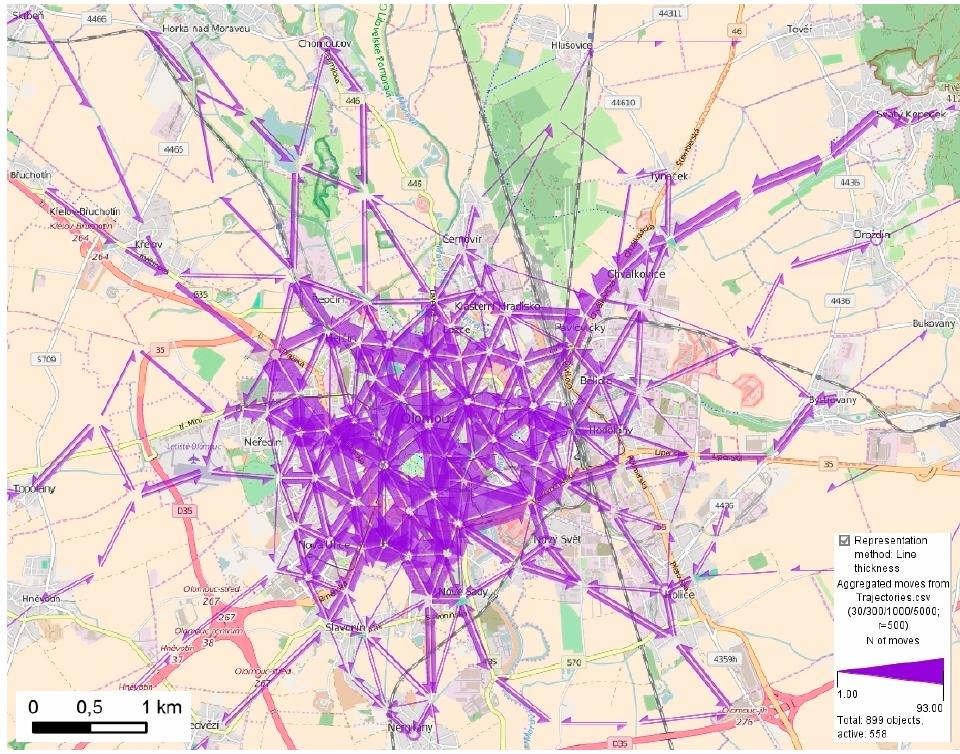
Figure 12. Dominant directions of movement in Olomouc according to all means of transport.